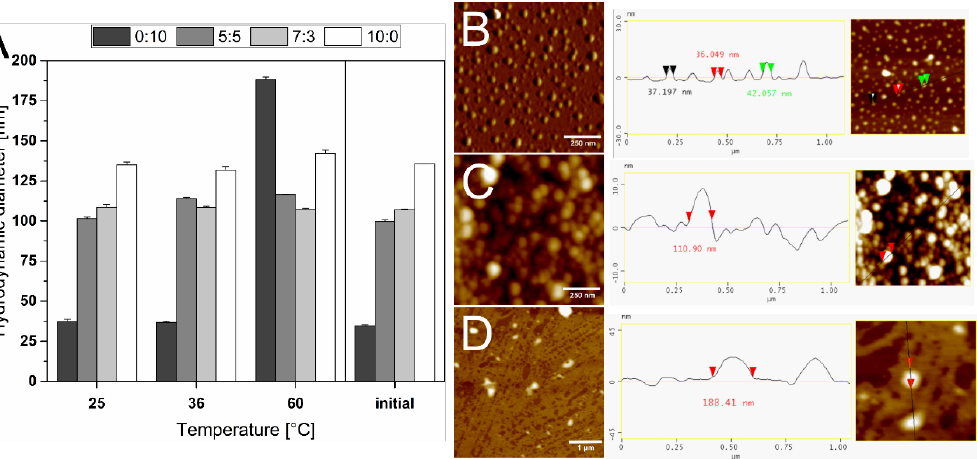
Figure 2. ( A ) The hydrodynamic diameter of liposomes composed of tetraether lipids (TEL) and Phospholipon 100H (Ph) in different molar ratios (0:10, 5:5, 7:3, 10:0; TEL:Ph) incubated for 4 h at 25, 36, and 60 ◦ C compared to initial values. AFM images in height or phase mode of ( B ) 0:10 TEL:Ph liposomes incubated for 4 h at 25 ◦ C, ( C ) 7:3 TEL:Ph liposomes incubated for 4 h at 25 ◦ C, and ( D ) 0:10 TEL:Ph liposomes incubated for 4 h at 60 ◦ C. Scale bars in B+C represent 250 nm. The scale bar in D represents 1 µ